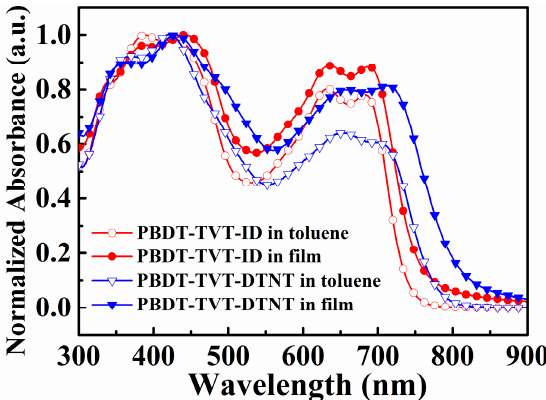
Figure 2. Normalized UV-visible absorption spectra of the polymers in toluene solution and thin films.